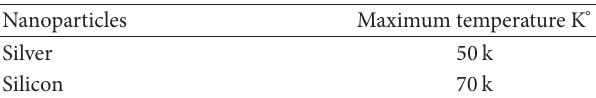
Table 2: Comparison between the Ag and Si NPs produced by 1064 nm has 10ns pulse duration. Nanoparticles Maximum temperature K